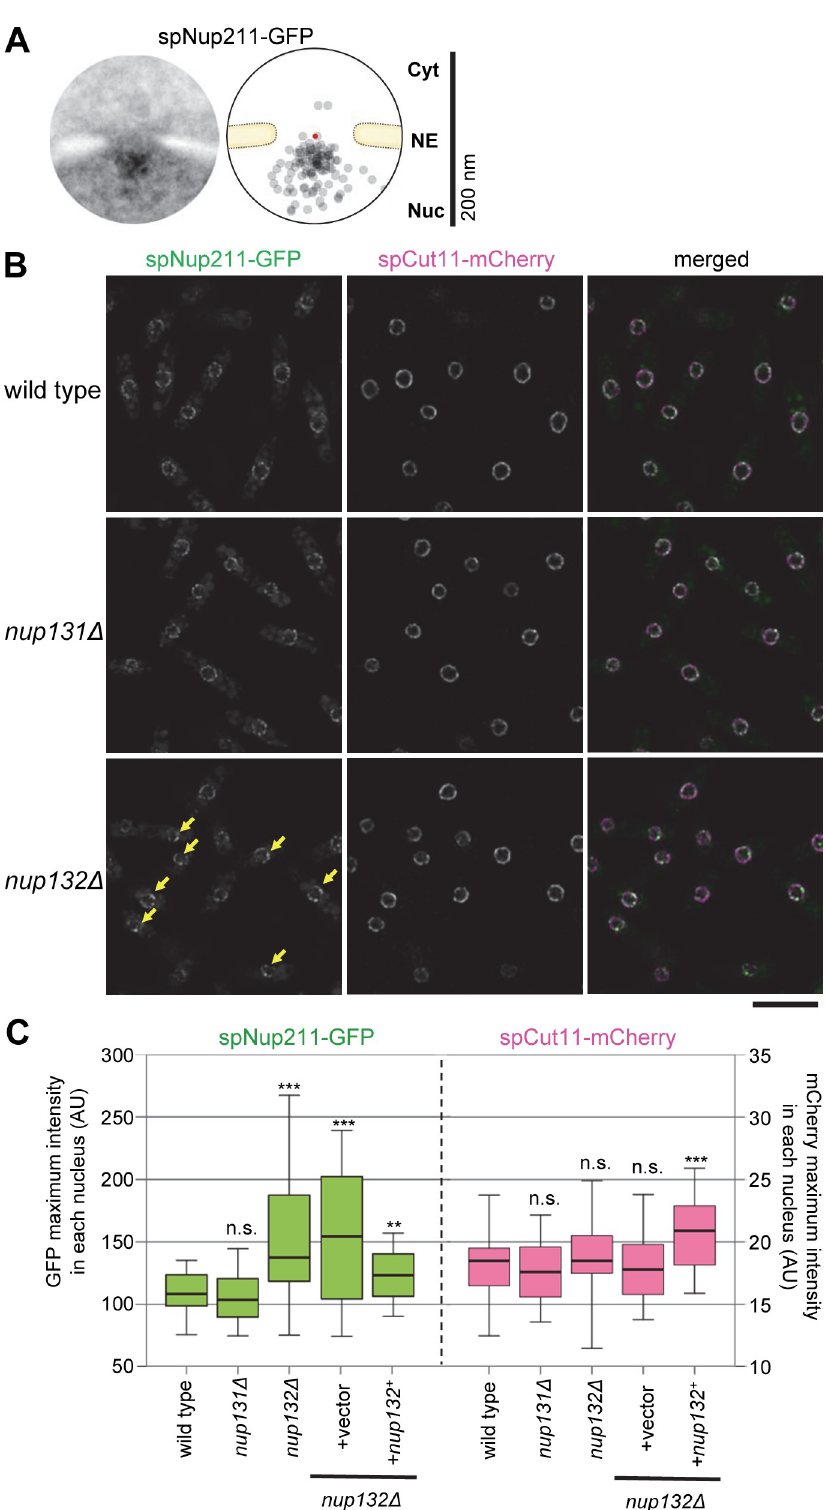
Fig 3. spNup132 is required for the distribution of the nucleoplasmic nucleoporin spNup211 at the NPC. (A) IEM of spNup211-GFP. For quantitative representation, a schematic drawing illustrating the distribution of immunogold particles based on 20 immunoelectron micrographs is shown. The red point indicates the pore center. Individual